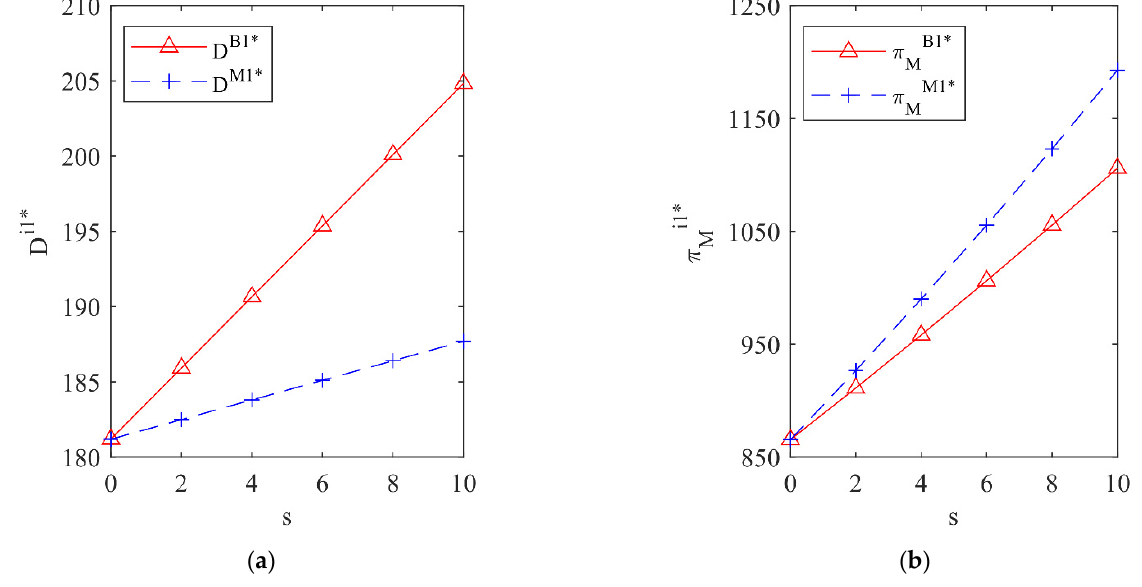
π under outsourcing pro- under outsourcing processing M M